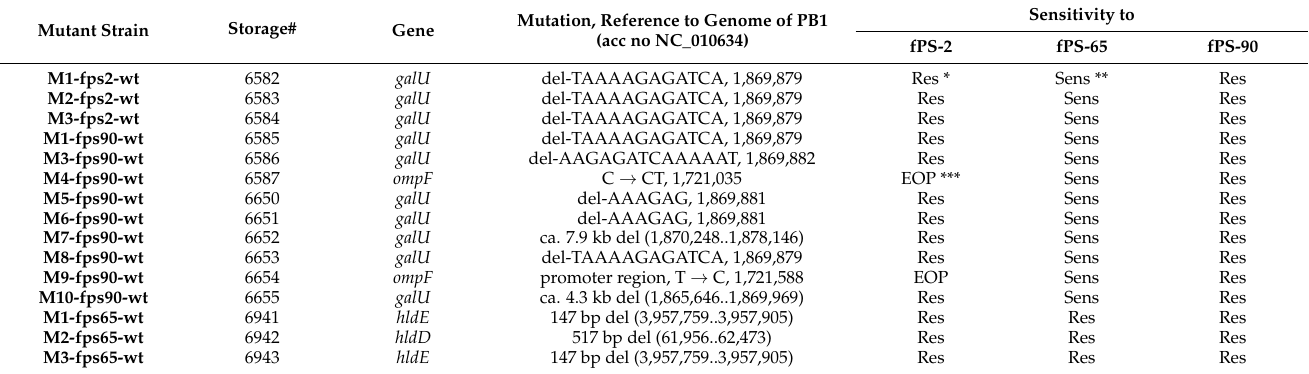
Table 1. Overview of phage-resistant mutants and their sensitivity to the fPS-phages. Mutant Strain Storage# Gene Mutation, Reference to Genome of PB1 (acc no NC_010634)